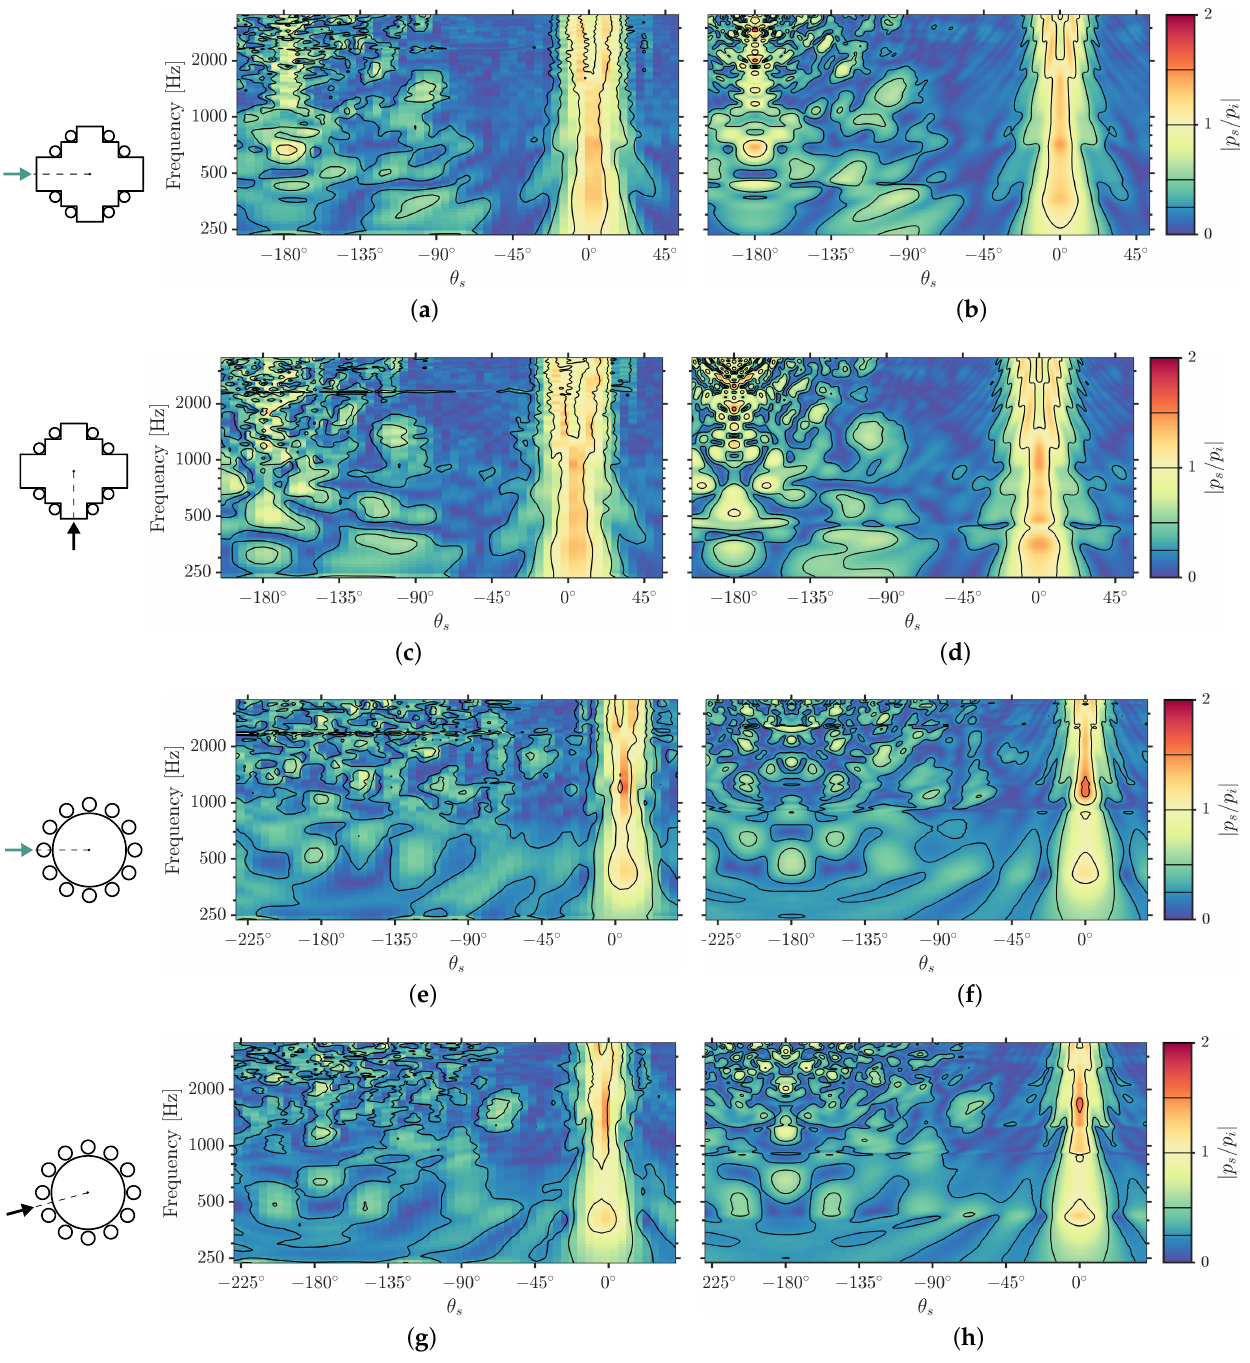
Figure A2. | p s / p i | for the piers with colonnettes C2 , with ( a , b ) θ 0 = 0° and ( c , d ) θ 0 = 90°, and N3 with ( e , f ) θ 0 = 0° and ( g , h ) θ 0 = 15°. Scale model measurements ( left ) compared to simulations ( right ). The frequency axis of the measurements is scaled according to the factors given in Table